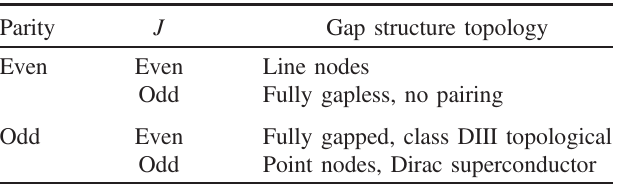
TABLE III. Gap structure of j J; 0 i pairing states. Gap structures topology of multicomponent time-reversal invariant pairing states with M ¼ 0 axial angular momentum. Odd-parity pairing states with odd J have bulk nodes with gapless quasiparticles described by the Hamiltonian of either Eq. (65) or Eq. (66). Notably, the odd-parity states with even J are fully gapped topological superconductors in class DIII, which break rotational symmetry and have subsidiary nematic order. Note that the results sum- marized here are not specific to the valence band Fermi surface, but also hold for a conduction band Fermi surface (i.e., electron